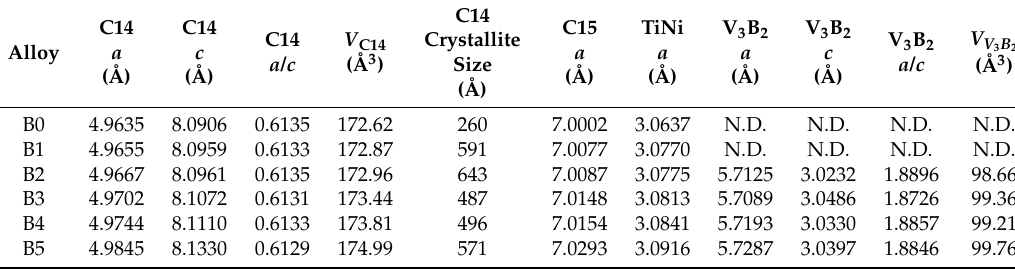
Table 2. Lattice constants a and c , a / c ratio, unit cell volume, and crystallite size of the main C14 phase of alloys B0 to B5 from the XRD analysis. Lattice information of the secondary phases are also included. N.D. denotes non-detectable.